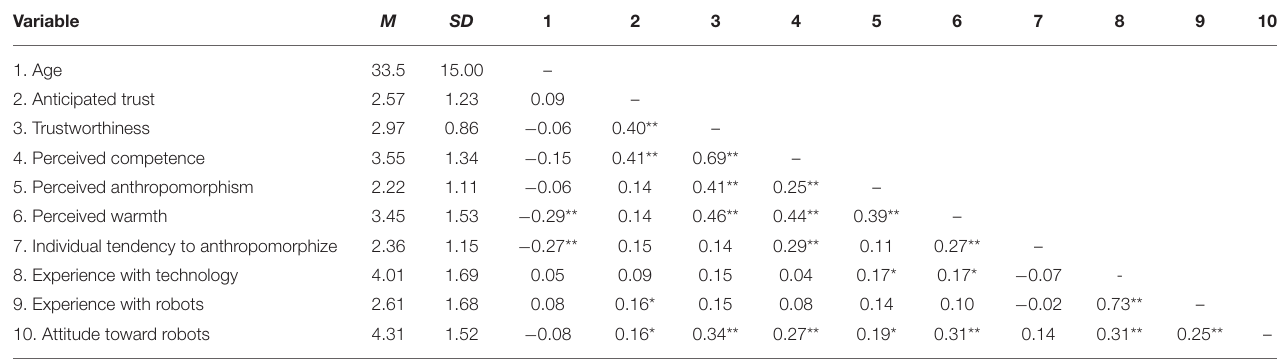
TABLE 2 | Means ( M ), standard deviations ( SD ), and Pearson correlations of relevant variables within the overall sample of study 1. Variable M SD 1